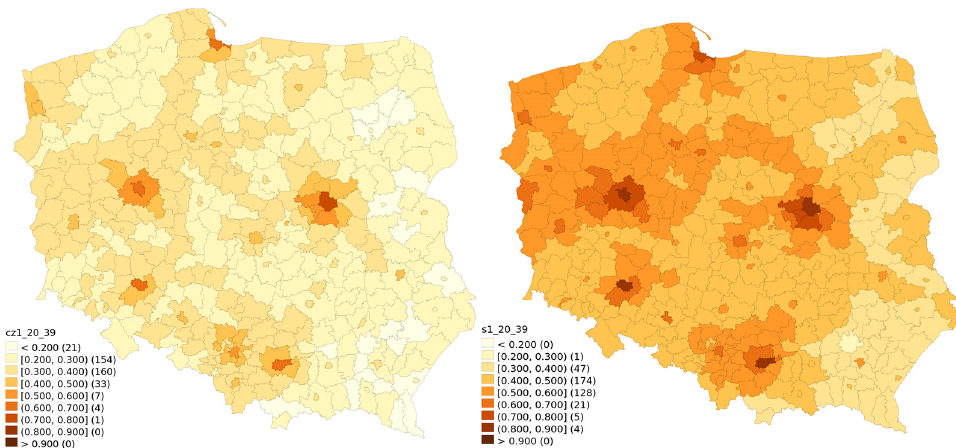
Figure 1. Vaccination rate for the 20–39 age bracket for 30 June 2021 and 31 January 2022.